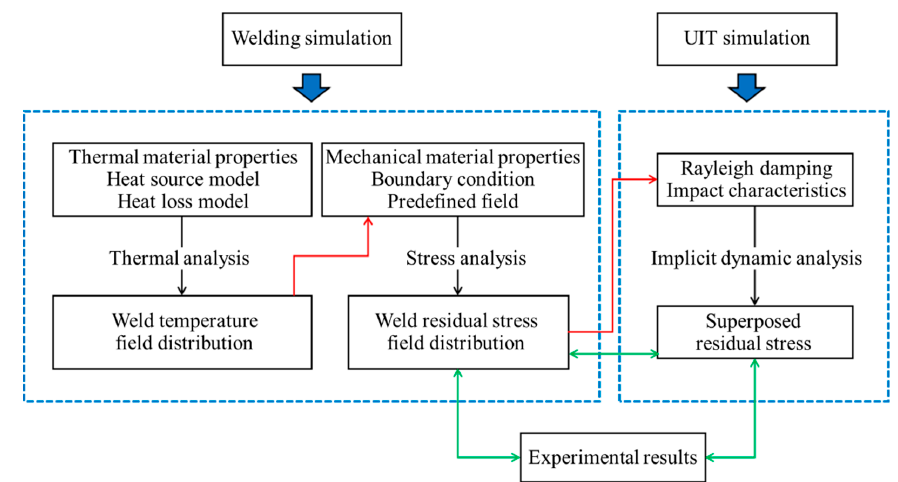
Figure 2. Flow chart of finite element simulation.